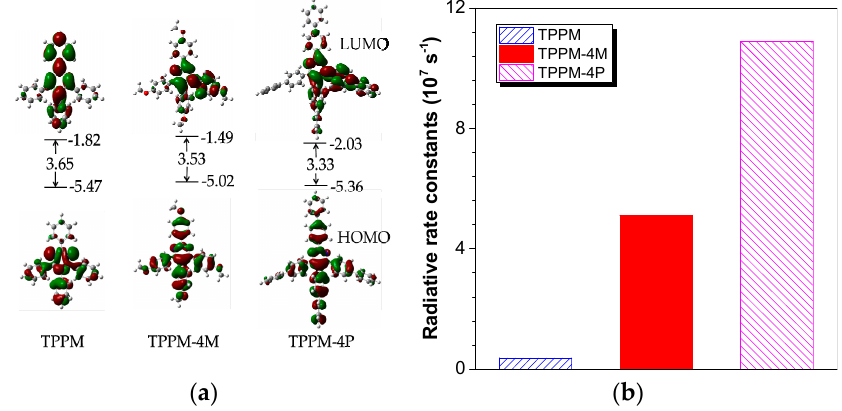
Figure 3. ( a ) Molecular orbital amplitude plots and energy levels of the HOMOs and the LUMOs of TPPM derivatives at the S 1 -geometry calculated at the B3LYP/6-31G(d, p) level; ( b ) Comparison of radiative rate constants of TPPM, TPPM-4M and TPPM-4P calculated in the isolated state.